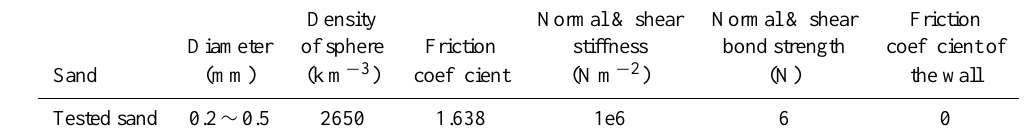
Table 2. Microscopic parameters of the sands for particle flow analysis.